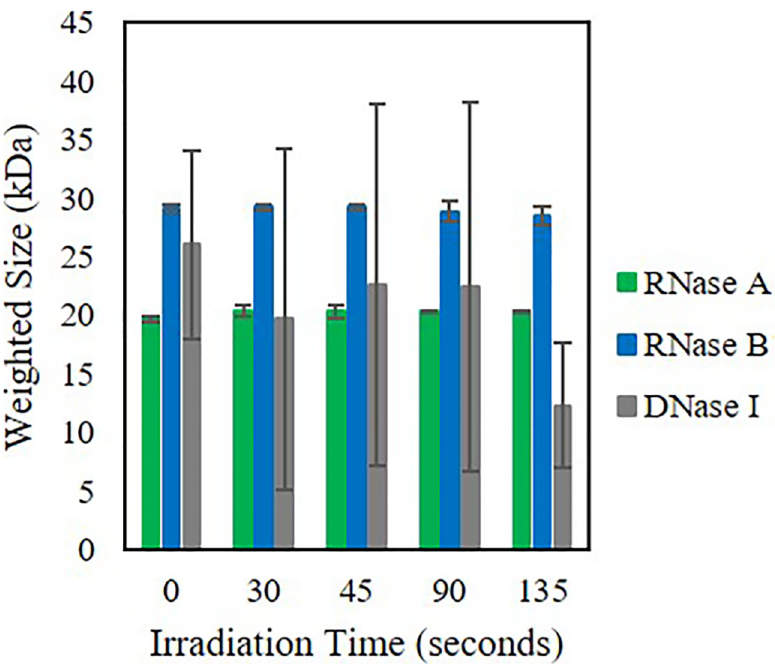
Fig 6. Weighted size (kDa) of RNase A, RNase B, and DNase I. Weighted size post microwave irradiation at 30% power, 60 seconds. In general, as irradiation time increases, the overall weighted nuclease size decreases and the error in the size becomes larger. This in indicative of an increasing number of varying size fragments with an overall degraded nuclease. Pre = No microwave irradiation.